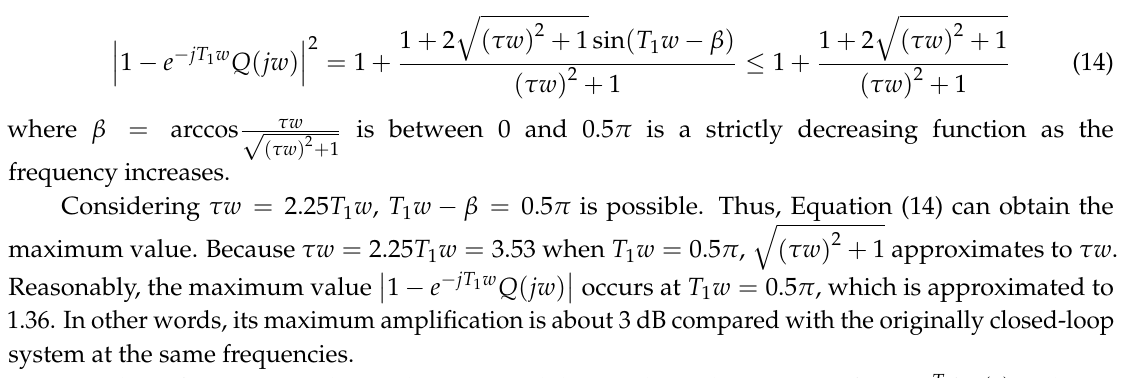
Figure 3. Bode response of )(1 1 sQe sT .